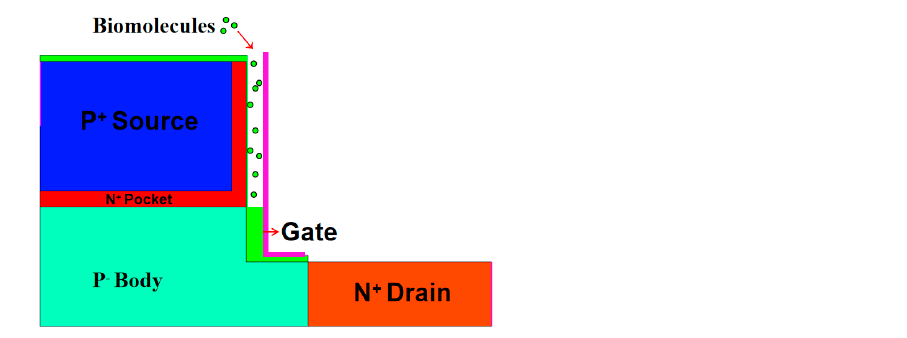
Figure 1. Schematic cross-sectional view of a dielectric-modulated L-shaped tunneling field-effect transistor (DM-LTFET) biosensor. Table 1. Device parameters used for the simulation.